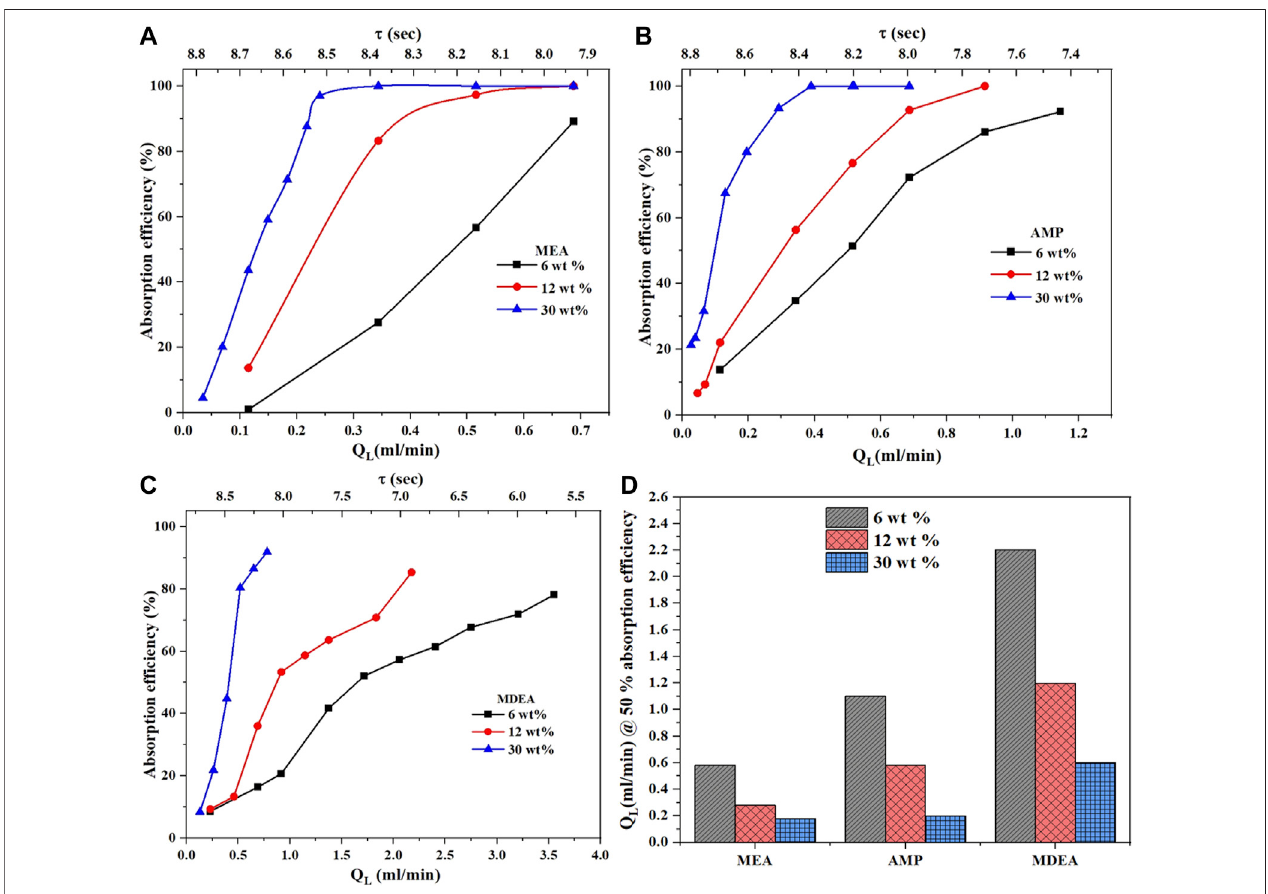
FIGURE 5 | Effect of amine concentration on absorption ef fi ciency for (A) MEA, (B) AMP, and (C) MDEA at a fi xed CO 2 fl ow rate of 6 ml/min and temperature of 30 ° C. Amine fl ow rate needed to reach 50% of absorption ef fi ciency for different amine concentrations (D) at a fi xed CO 2 fl ow of 9 ml/min and temperature of 30 ° C.